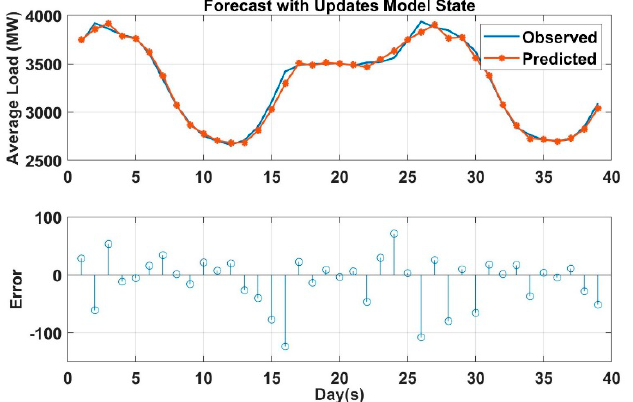
Figure 17. Comparison of per-day forecast future time series with test data (observed value).